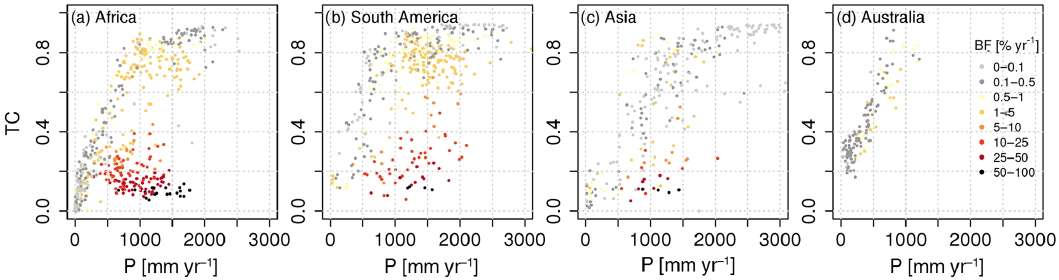
Figure 7. Same as Fig. 4 for JSBACH-SPITFIRE but with pre-industrial land